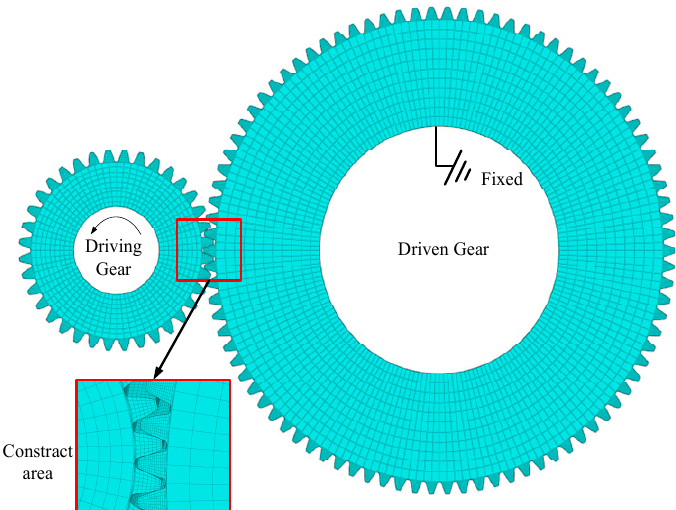
Figure 3. Meshing stiffness solution model.